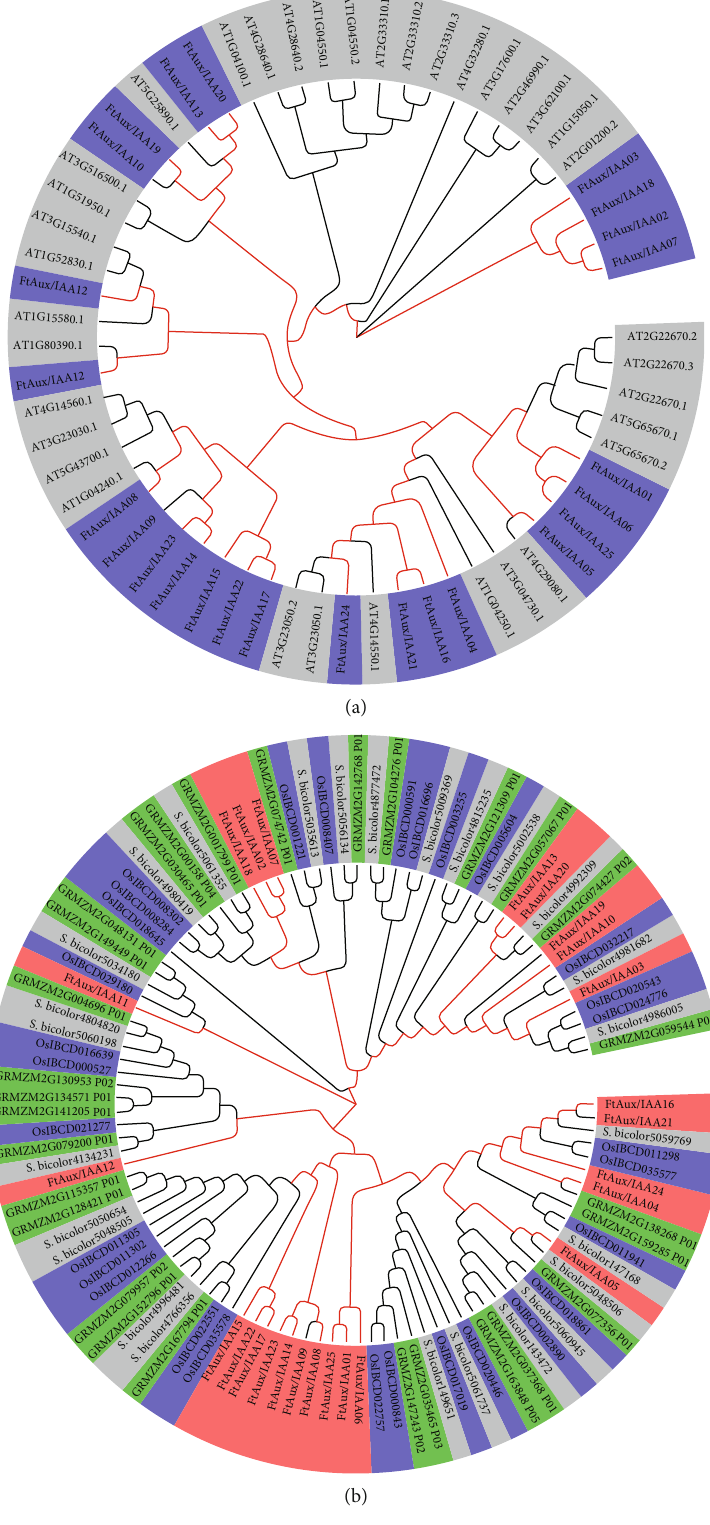
Figure 4: Phylogenetic relationship of Aux/IAA proteins. (a) The tree was reconstructed using Aux/IAA sequences of Arabidopsis thaliana (gray) and buckwheat (blue). Evolutionary distances were computed using the p - distance method and expressed in units of the number of amino acid substitutions per site. (b) The tree was reconstructed using Aux/IAA sequences in Oryza sativa (blue), Sorghum bicolor (gray), Zea mays (green), and buckwheat (red). Evolutionary distances were computed using the p-distance method and expressed in units of the number of amino acid substitutions per